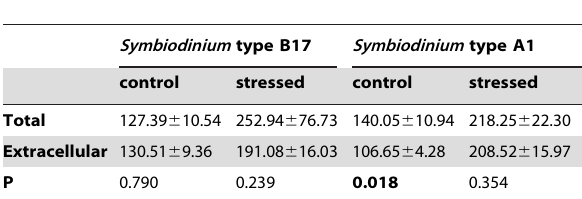
Table 1. Total and extracellular glycerol levels in Symbiodinium cells exposed to an osmotic